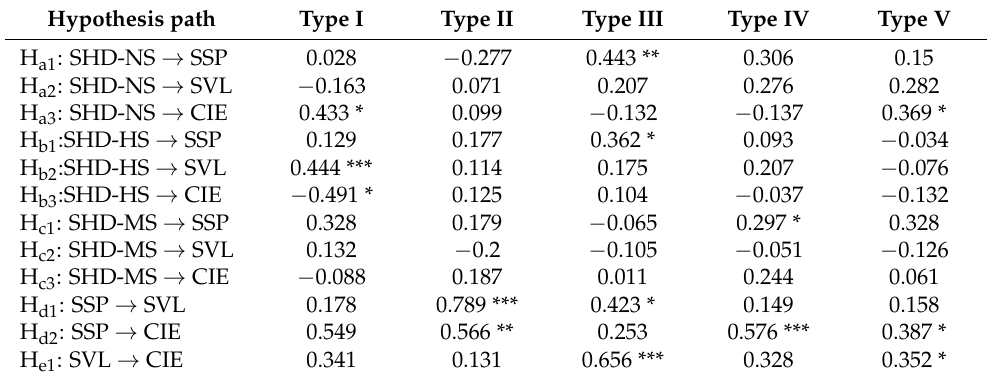
Table 8. Results of multiple-group analysis in different functional zones.